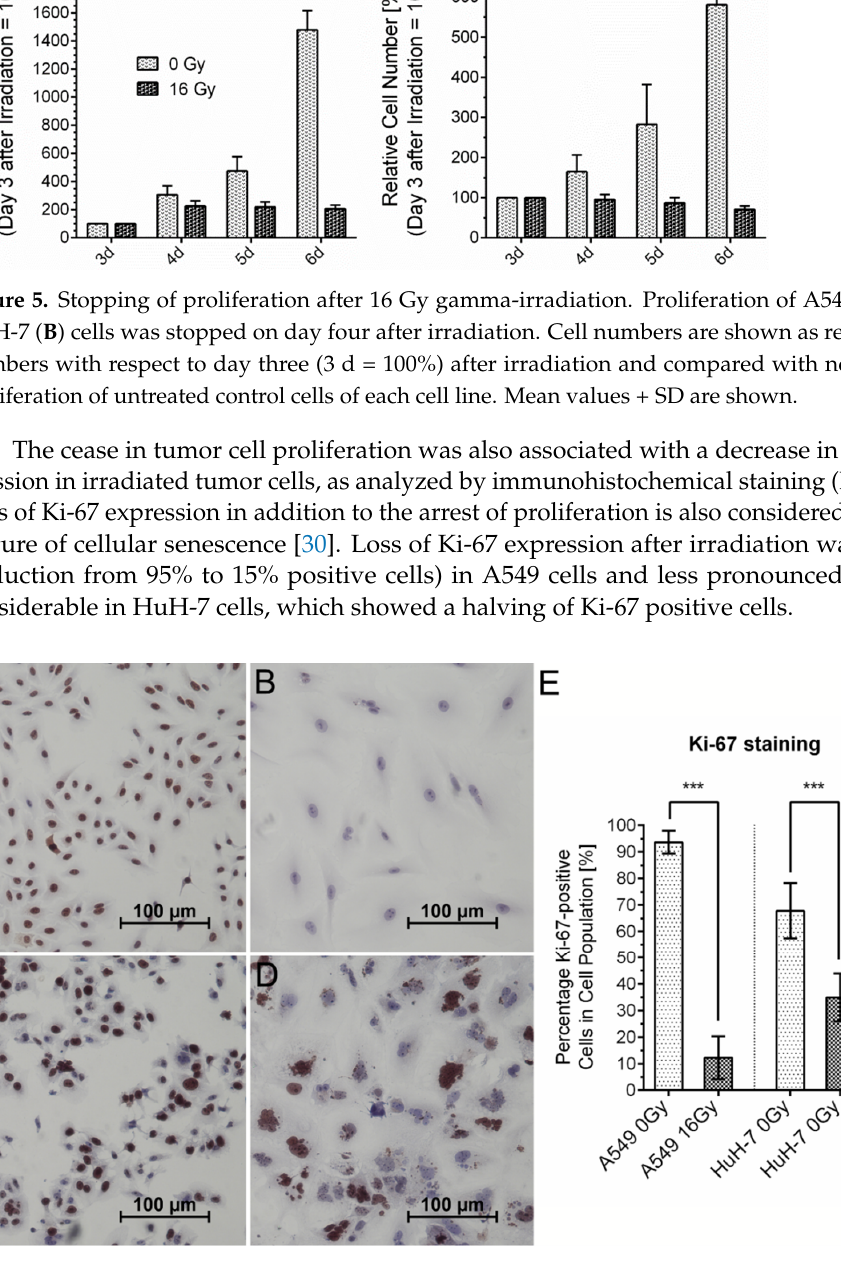
6 of 22 Figure 4. Increase in cell diameter after 16 Gy gamma-irradiation. After irradiation, the diameter of A549 cells (left) and HuH-7 cells (right) increased significantly until day four (4 d), followed by a slower but steady increase in cell diameter until day seven (7 d) after irradiation. Within the first four days, the cell diameter increased sharply from 20.9 µm ± 6.5 µm to 45.6 µm ± 17.6 µm in A549 cells and from 23.2 µm ± 7.9 µm to 40.5 µm ± 19.4 µm in HuH-7 cells. In the following days, the increase in cell diameter leveled off and reached values of 61.1 µm ± 23.2 µm in A549 cells and 66.3 µm ± 32.4 µm in HuH-7 cells on the seventh day after irradiation. Concomitantly, the size distribu- tion of the cell population broadened. Shown are box blots with 5–95% percentiles and median, outliers are shown as dots, unpaired two-tailed t -test, comparison between untreated control cells and irradiated cells at the different time points, *** p < 0.001. The observed morphological changes after gamma-irradiation were associated with